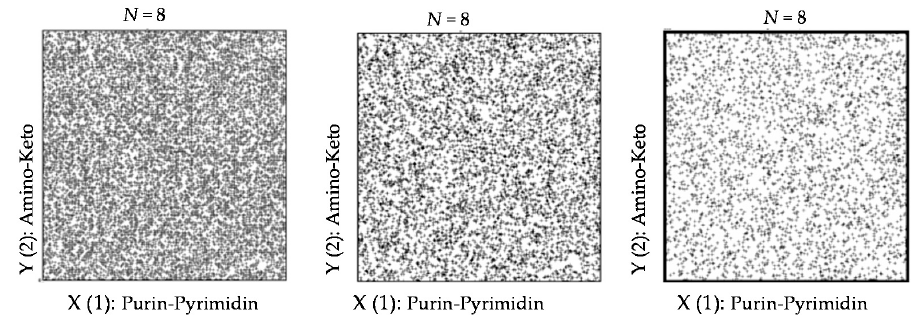
Figure 7. Examples of visual patterns of a random nucleotide sequence with 100,000 nucleotides (pentagramon.com) in cases of its division with N = 8, 16, 28.